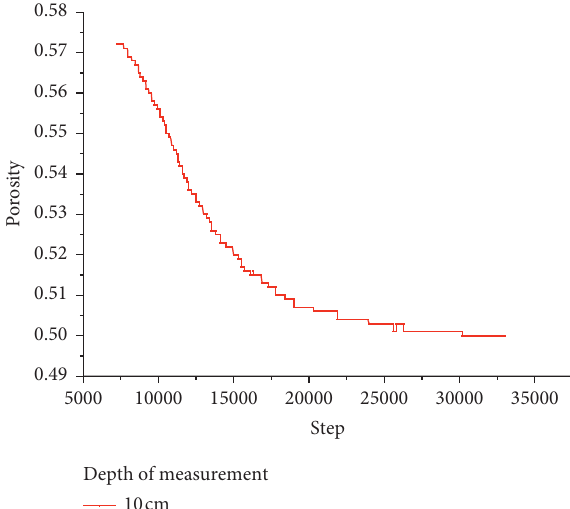
Figure 12: Curve of porosity change of 30 cm thick reclaimed soil with one compaction.